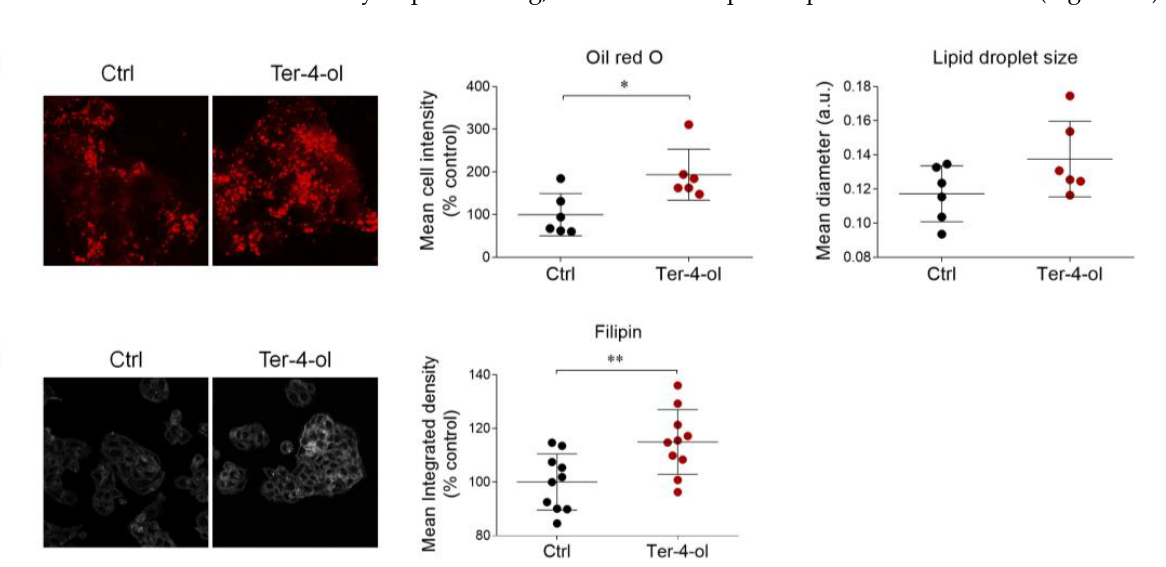
7 Figure 5. LEO induces SREBP-2 expression and nuclear translocation in HepG2 cells. Left panel: representative immunofluorescence of SREBP-2 (red) upon 24 h of LEO administration (0.005%). DAPI (blue) was used to counterstain the nuclei. Right panel: quantitative evaluation of the total and nuclear SREBP-2 protein fluorescence intensity. n = 7 different experiments. Data represent